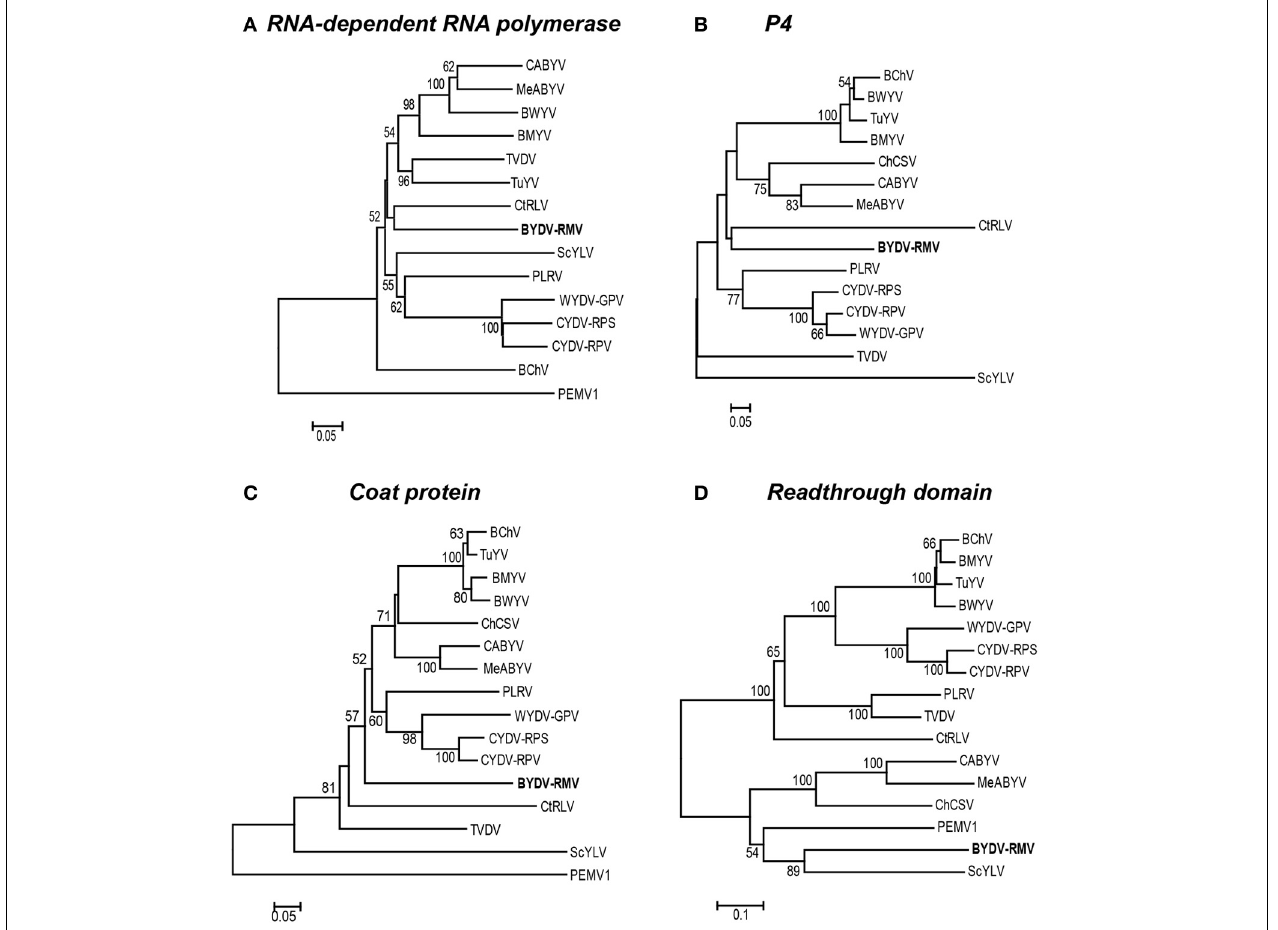
FIGURE 5 | Phylogenetic relationships of four luteoviral proteins. For each protein, the amino acid sequences were aligned using the MUSCLE algorithm in the JalView program and subsequently used to generate a Neighbor-Joining tree with the percentage of 1000 bootstrap replicates